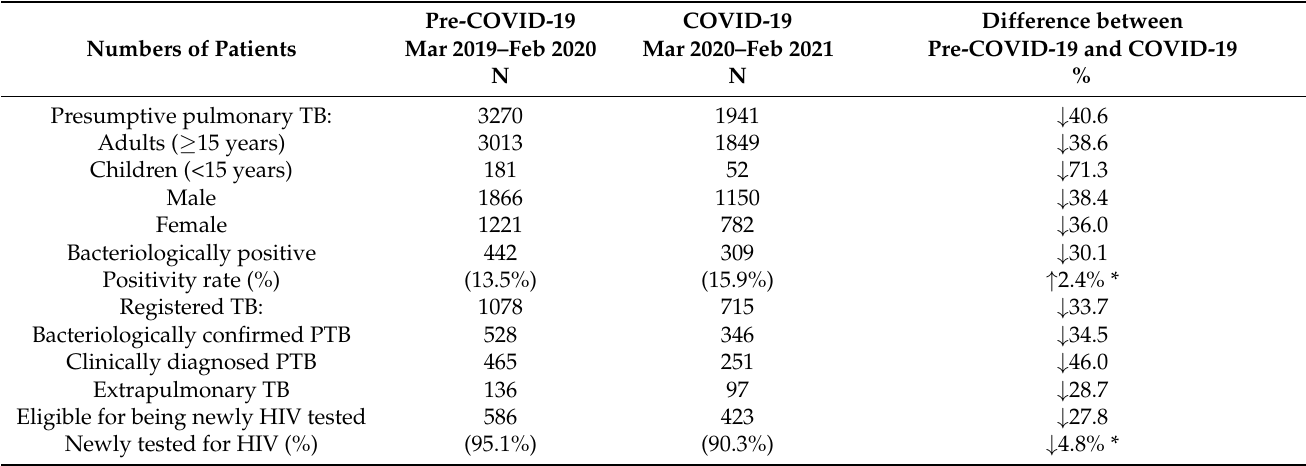
Table 1. Characteristics of persons with presumptive pulmonary TB and registered TB in 10 health facilities in Harare, Zimbabwe, during pre-COVID-19 and COVID-19